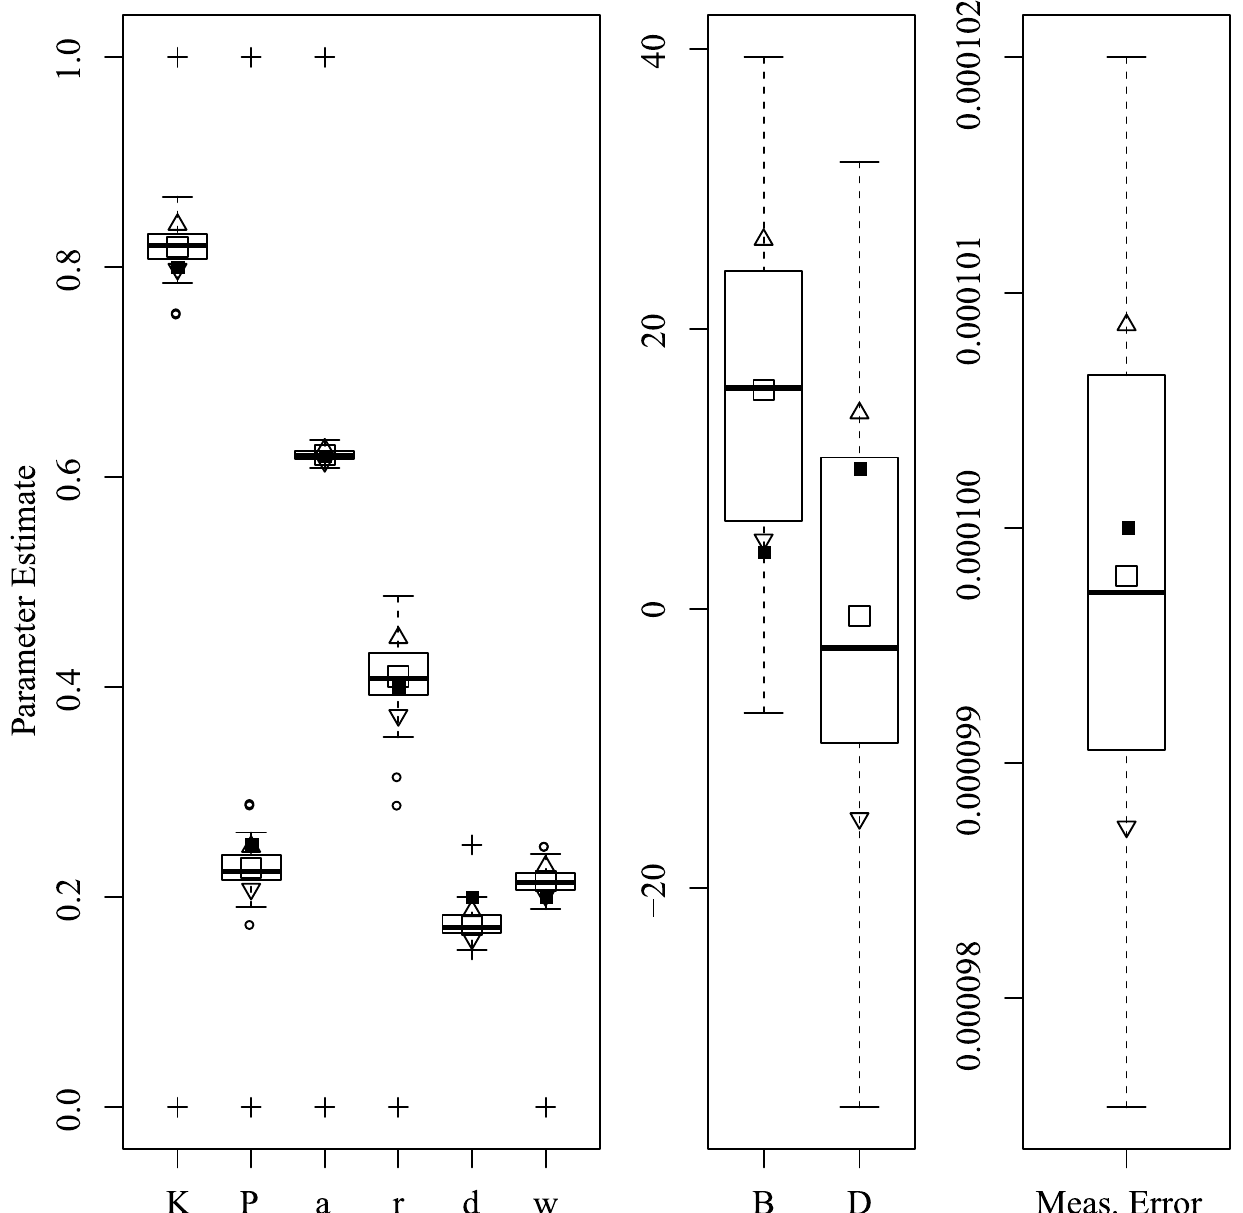
Fig 3. Parameter recovery results for the Asai et al. replication set. Black squares: data-generating value; Empty squares: Estimate mean; Triangles: Upper and lower std. dev.; Circles: Outliers; Crosses: Optimization boundaries.